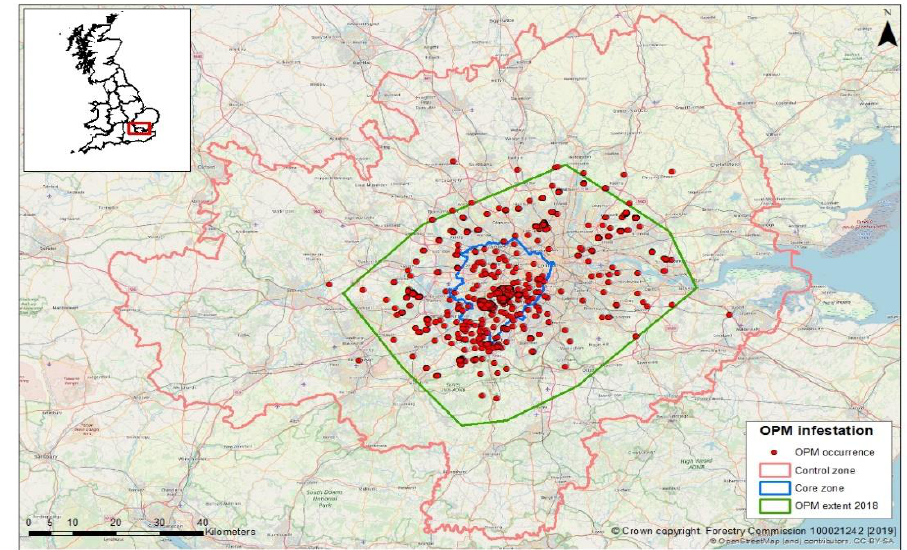
Figure 1. Map of OPM distribution and zoning areas in Greater London and in some surrounding counties. The red dots indicate OPM presence, the blue outline the core zone, red outline the control zone and the green outline the previous year’s extent of OPM presence.